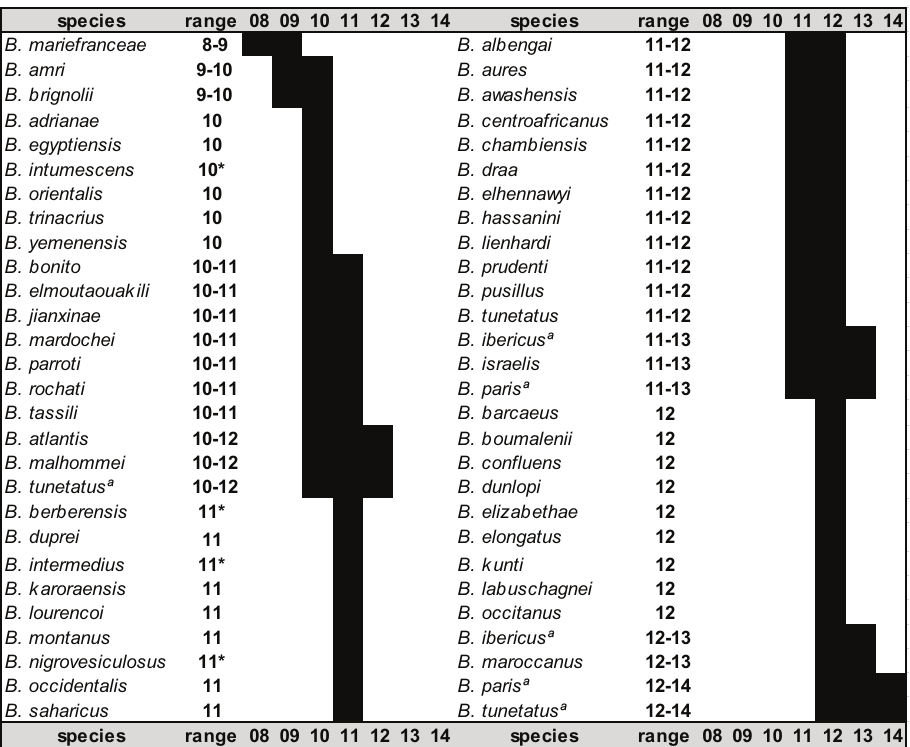
Figure 9. Graphical representation of the variation in the number of rows in the movable finger of all Buthus species. ª Species for which the bibliographic ranges are conflicting. * Number of rows in species identified by us from images of the type specimens may be